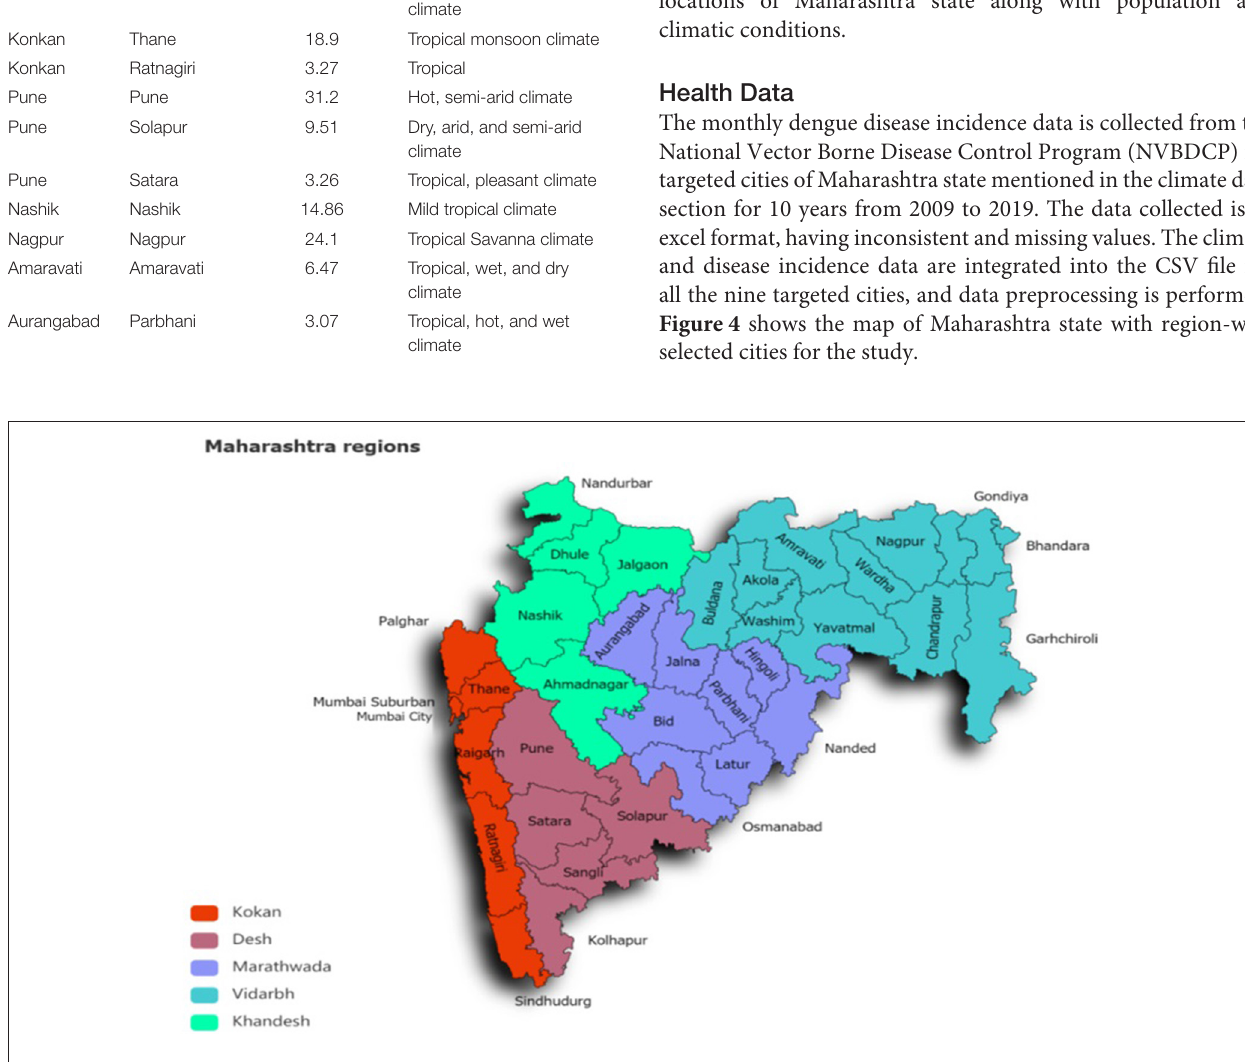
Frontiers in Public Health |